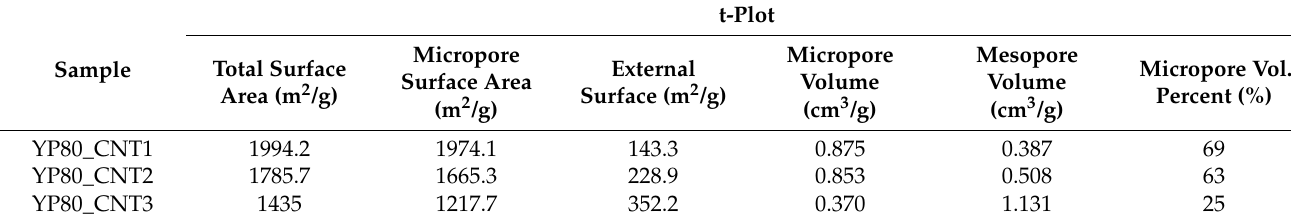
Table 2. Some physical parameters obtained from the